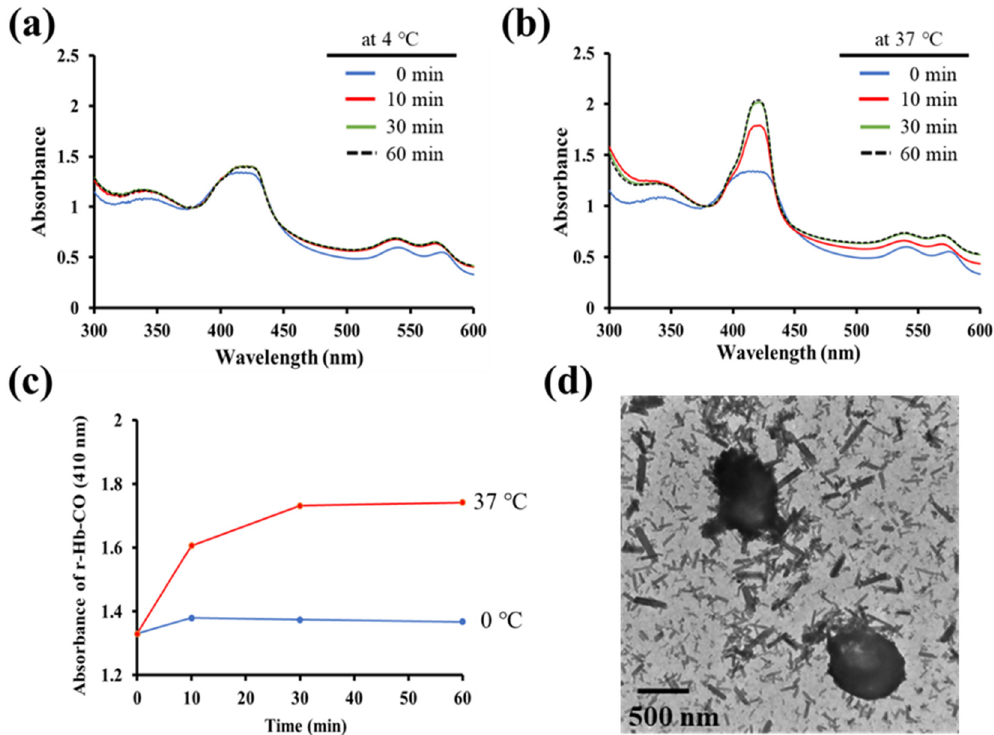
Figure 6. Evaluation of CO release from IC ‐ loaded PLGA MVs. ( a , b ) The UV–vis spectra of reduced hemoglobin were measured to monitor the CO release from IC ‐ loaded PLGA MVs at 4 and 37 °C for 0–60 min. ( c ) The dynamic CO release curves were obtained through the evaluation of the absorbance of r ‐ Hb ‐ CO at 410 nm. ( d ) A TEM image of the broken IC ‐ loaded PLGA MVs.